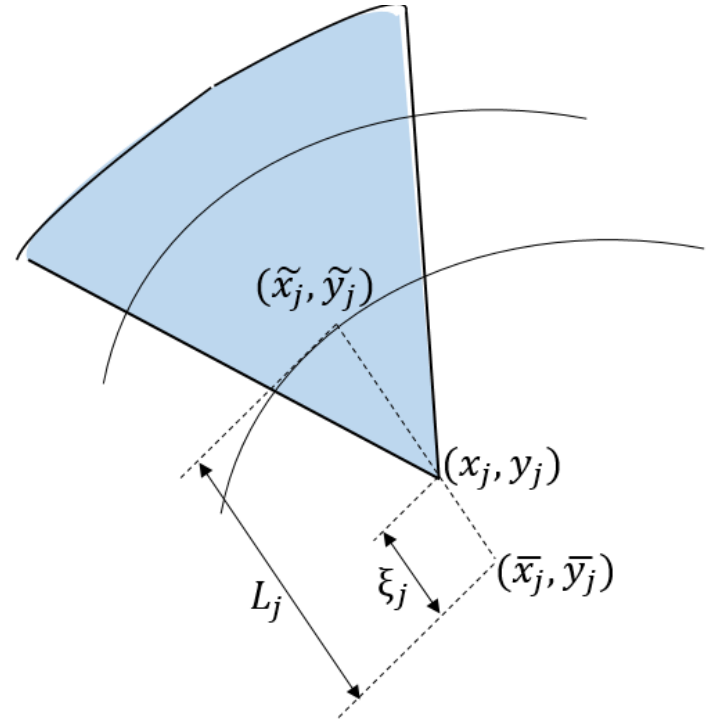
Figure 14. ξ j ∈ [ 0, L j ] is the varying variable for finding approximate maximum coverage in given sensing